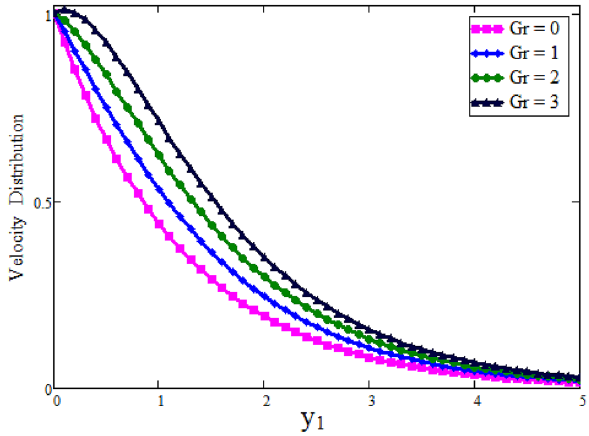
Figure 5. Velocity profile against y 1 due to Gr , when: t = 0.25 , φ = 0.04 , Pr = 6.2 , α = 0.2 and (cid:31) = 0.01 .